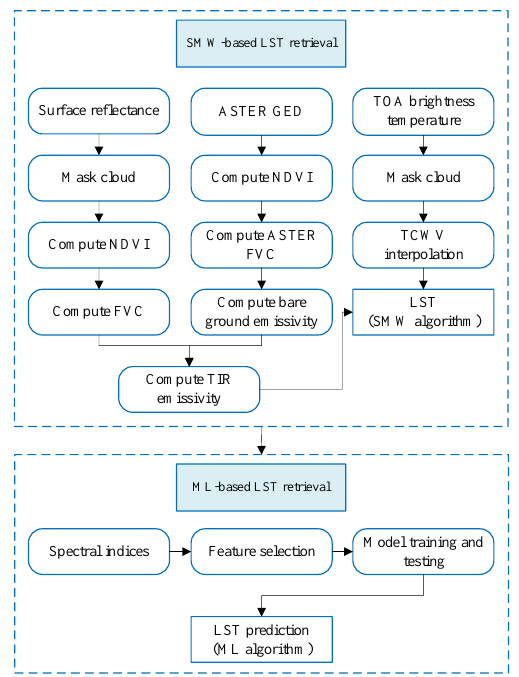
Figure 2 . Overview of the